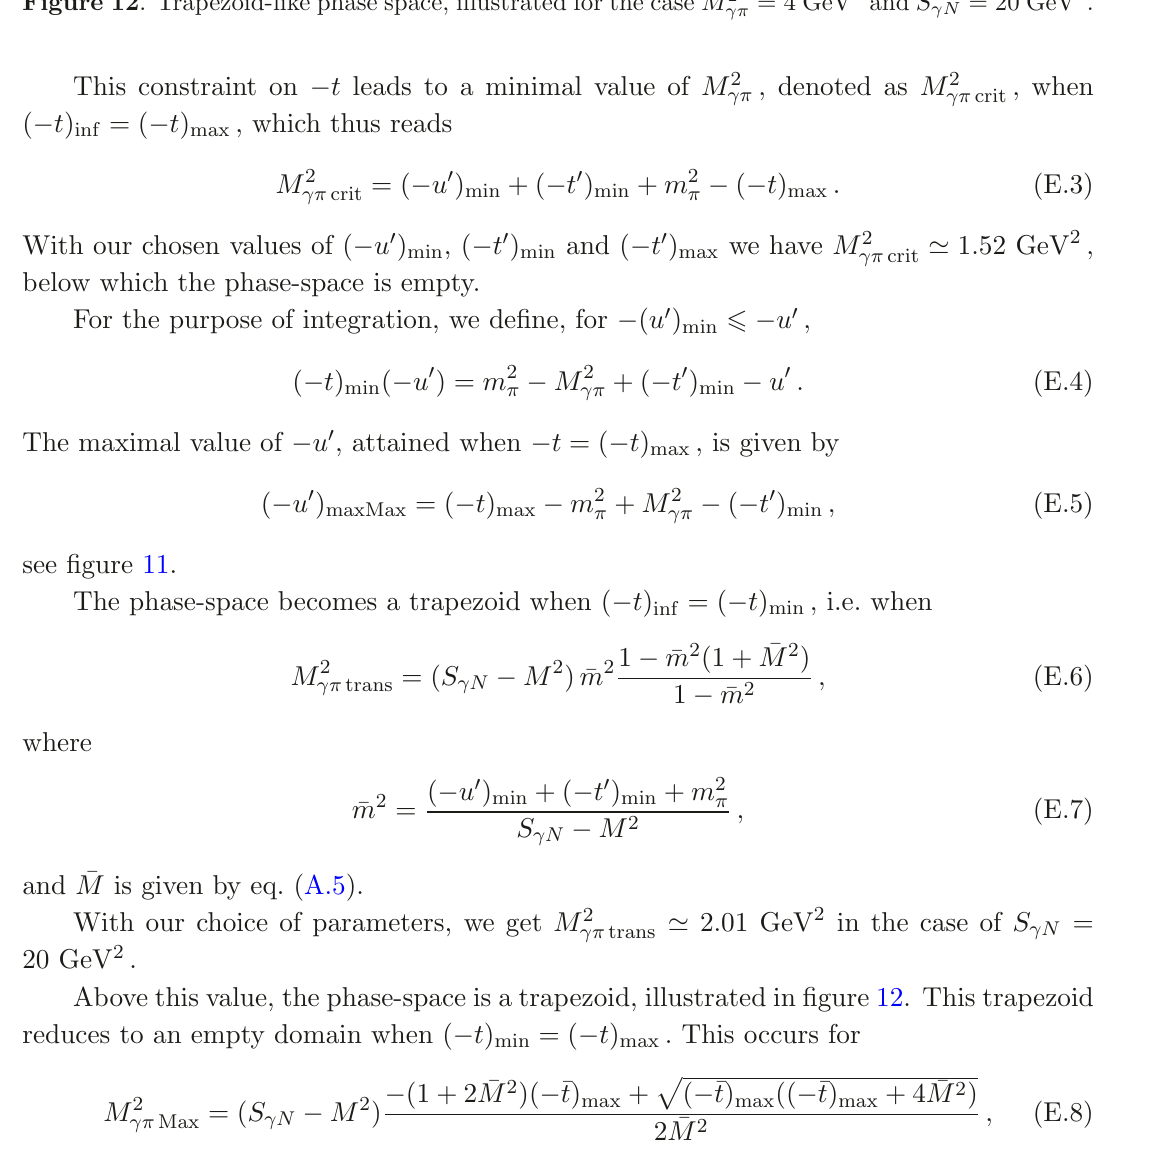
= 4 GeV 2 and S γN = 20 GeV 2 γπ